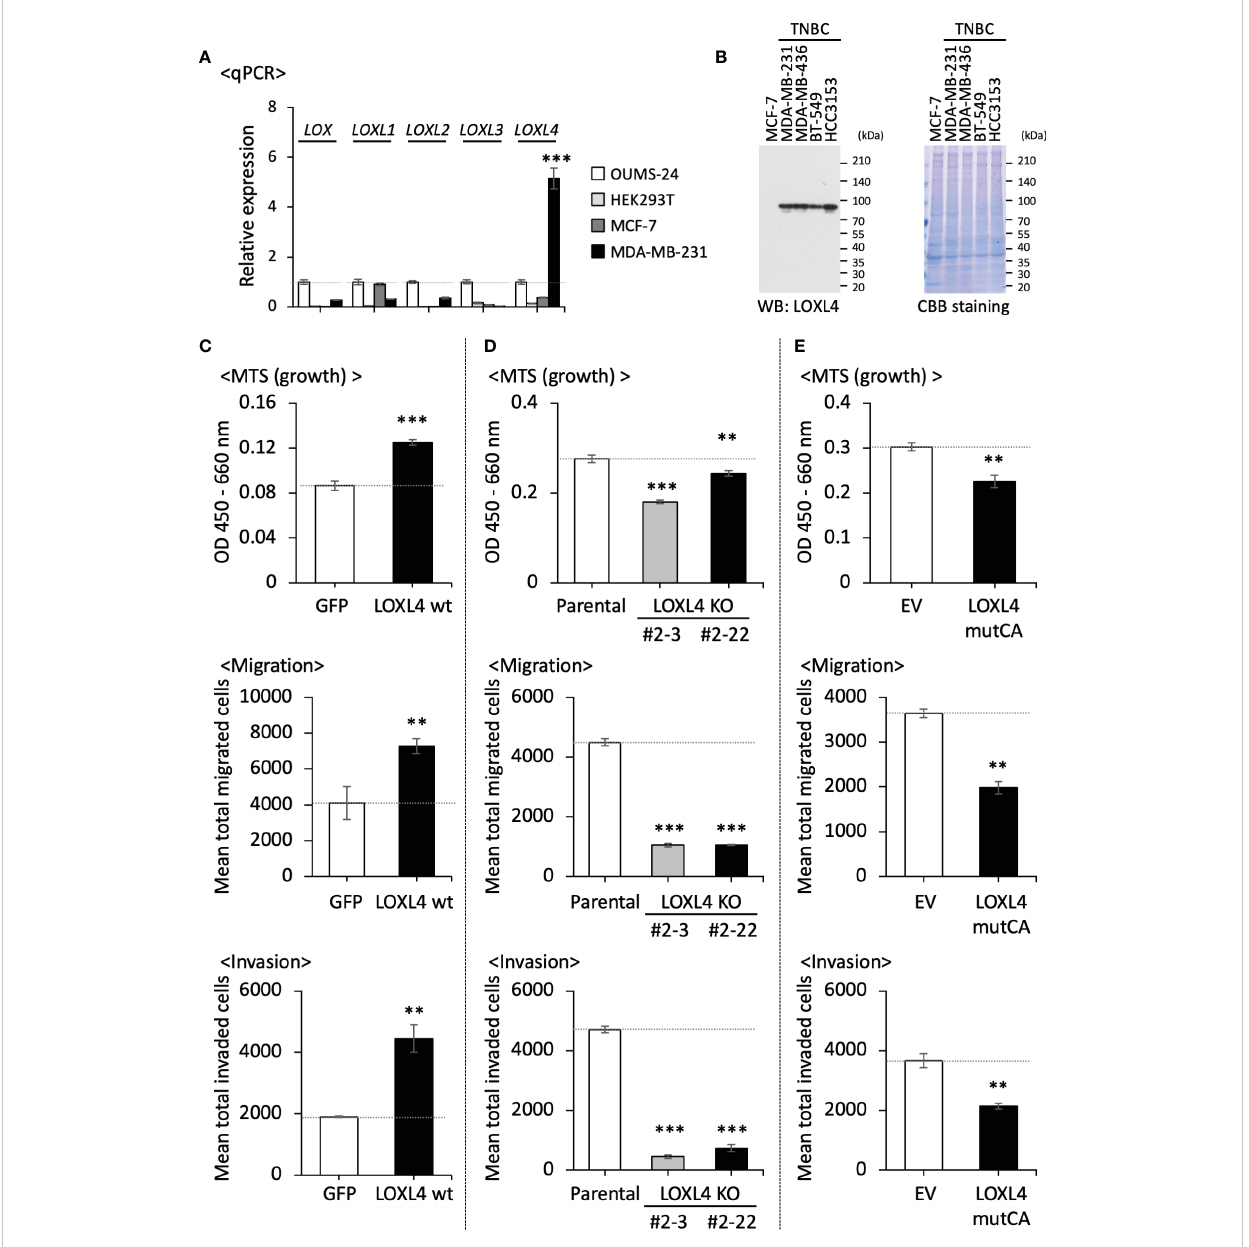
FIGURE 1 The bene fi cial roles of LOXL4 in the growth, migration, and invasion of triple-negative breast cancer (TNBC) cells in vitro . (A) : A real-time qPCR was performed to determine the endogenous levels of LOX family mRNAs in the indicated cells. TBP mRNA was used as a control for the analysis. (B) The intrinsically expressed LOXL4 protein in the indicated cell lines was also detected using the WB procedure. (C, E) We evaluated the growth ( upper ), migration ( middle ), and invasion ( lower ) abilities of the established MDA-MB-231 sublines with the stable overexpression of the wildtype of LOXL4 (LOXL4 wt subline) (C) , the genetic ablation of the intrinsic LOXL4 gene (LOXL4 KO #2-3 and #2-22 sublines) (D) , and the stable overexpression of mutant LOXL4 losing the catalytic activity (LOXL4 mutCA subline) (E) . Data are mean±SD. **p<0.01,